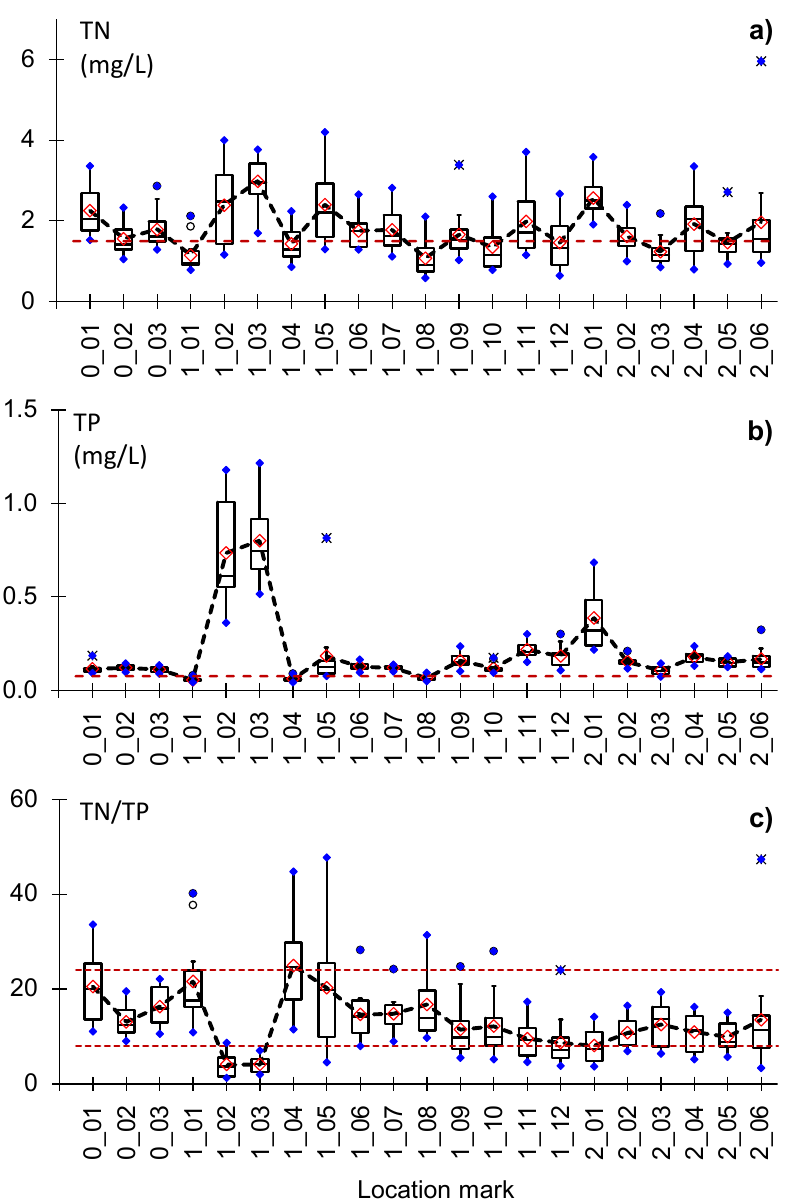
Figure 3. Spatial distribution of: ( a ) TN concentrations, ( b ) TP concentrations and ( c ) TN:TP mass ratios in examined water samples. Red lines indicate eutrophic status limits ( a ) TN > 1.5 mg/L, ( b ) TP > 0.075 mg/L and ( c ) TN/TP mass ratio of potentially N-limited (TN/TP < 8) or P-limited (TN/TP > 24).